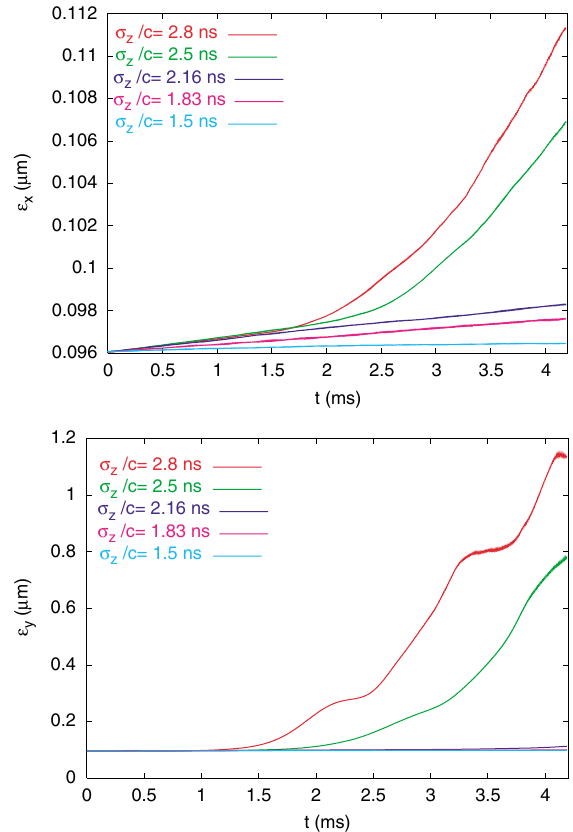
FIG. 14. (Color) Horizontal (upper panel) and vertical (lower panel) emittance growth over 2000 turns for different bunch (cid:1) 4 (cid:2) 10 10 p = b . For each case, the bunch has lengths and N b been rematched by keeping a constant longitudinal emittance and adjusting the synchrotron tune (different vertical scales are used in the two